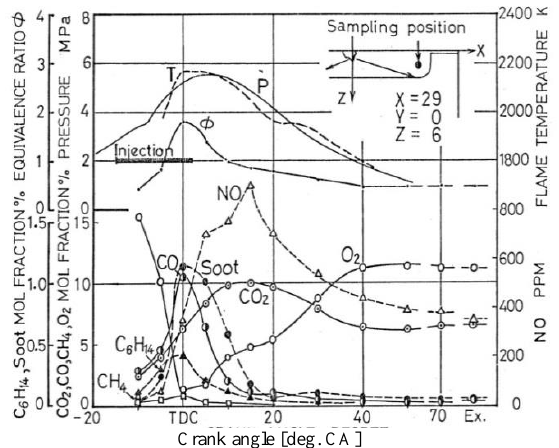
Fig. 1. Gas sampling results in comparison with flame temperature Ahn [16] demonstrated the flame temperature measure- ment procedure using the two-color method with color film images of the diesel flame. The conventional mechanical high-speed film cameras have been replaced by electronic high-speed digital cameras (hereinafter designated as high- speed digital cameras), which can digitize and record